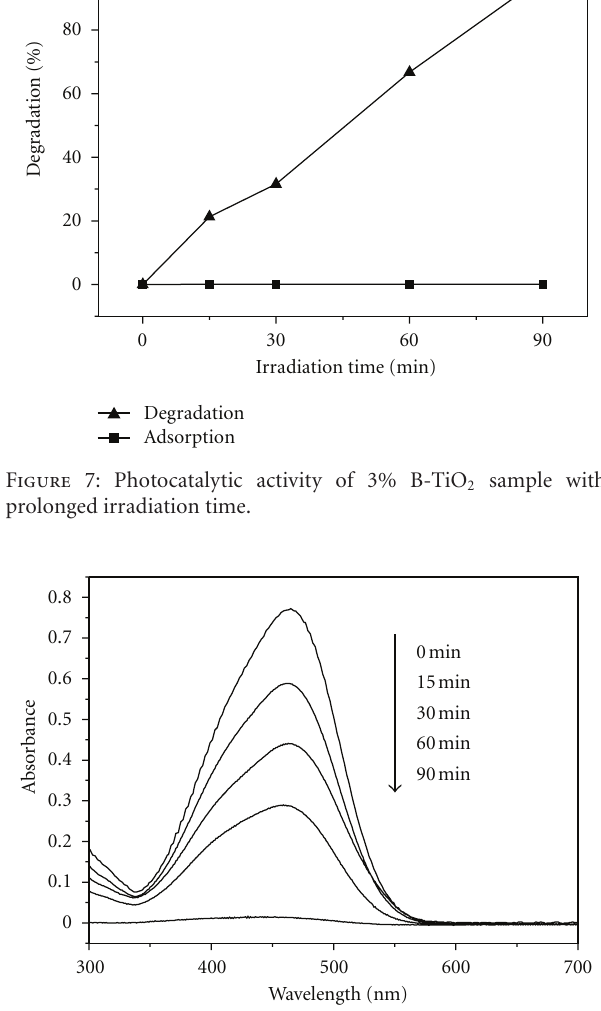
Figure 8: Absorption spectra of methyl orange solution during irradiation in the presence of 3% B-TiO 2